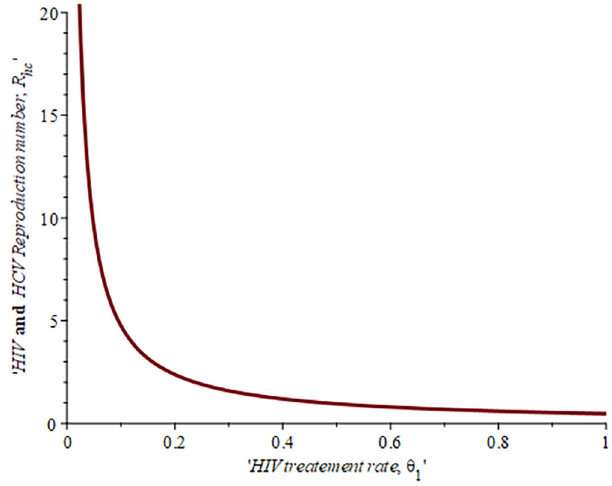
Figure 13. Impact of HIV treatment rate on HIV-HCV co-infection reproduction number.